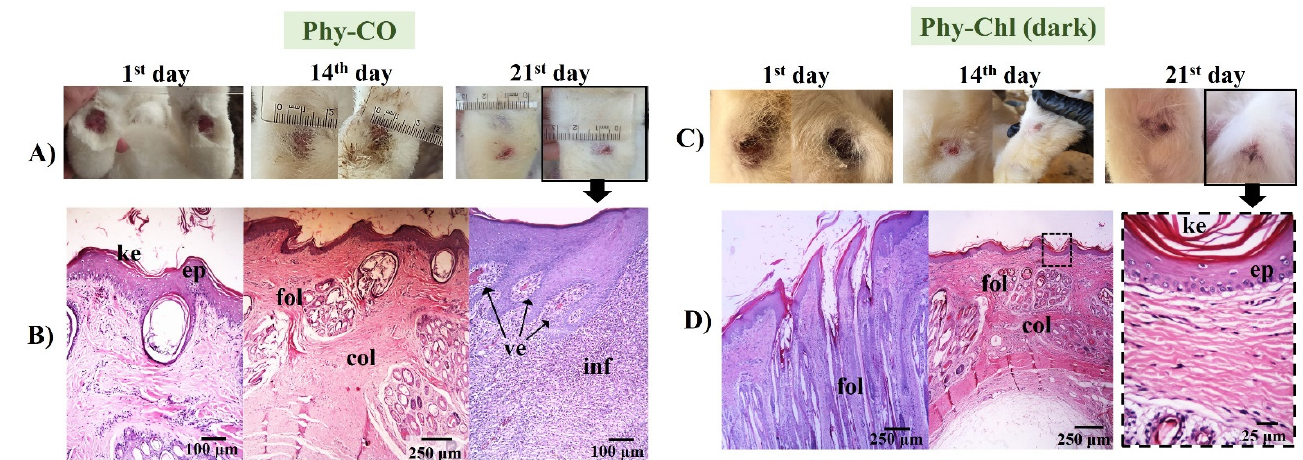
Figure 12. ( A , C ) Macroscopical aspects of the plantar face of feet in rabbits during Phy-CO and Phy-Chl (dark, without PDT use) treatment. ( B , D ) Histology of the last day of each treatment. The arrow from the photo of the feet indicates that the paw was analyzed histologically. The images show the keratin layer (ke), the stratified keratinized epithelium (ep), collagen presence (col), hair follicles (fol), blood vessels (ve), and signs of inflammation (inf). ( B – D ) Paraffin section, HE.